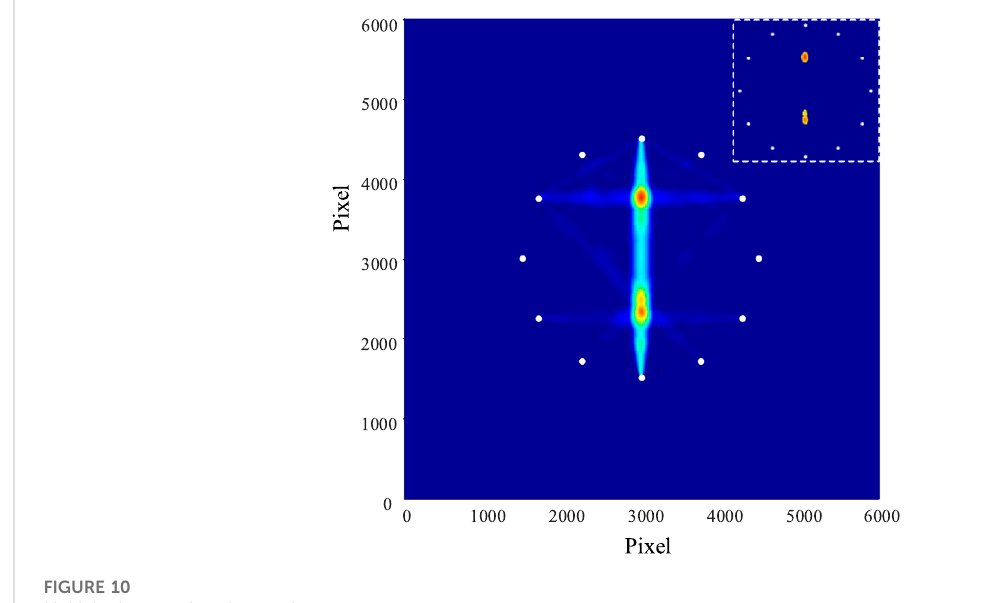
FIGURE 10 Multiple damages imaging result.